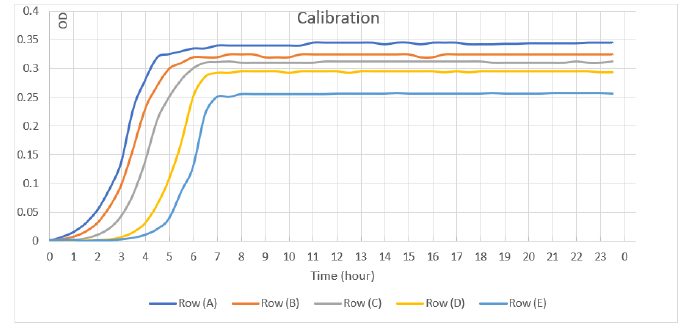
Figure 4. Calibration test results. Bacterial growth after 5 consecutive dilution transfers.